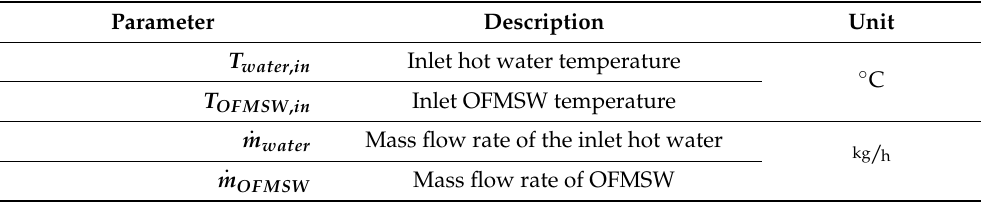
Table 1. The input parameters to the